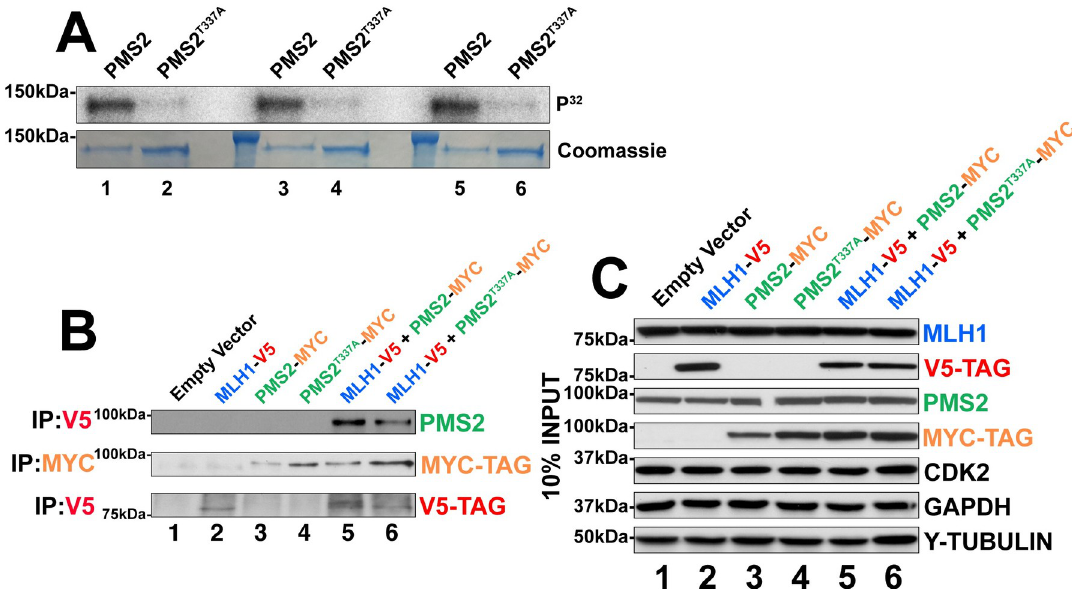
Fig 2. CDK2 phosphorylation of full-length PMS2 and its effect on the complex with MLH1. (A) CDK2/cyclin A2 kinase assay directed against GST-tagged fusion PMS2 (lanes 1,3,5) or PMS2 T337A (lanes 2,4,6) full length proteins. Upper panel shows the phospho- image of each protein and represents the amount of radiolabelling occurring following phosphorylation by CDK2/cyclin A2. The lower panel shows the Coomassie staining of radiolabelled proteins to indicate equal loading in each lane. (B) IP-western blot analysis of transfected MLH1-V5 or PMS2-MYC proteins from HEK293T cells. Antibodies used for immunoprecipitation are shown at the left hand side whilst antibodies used for detection are shown on the right hand side of the blot. Correct expression of tagged proteins is detected by the V5 or Myc tag following their respective immunoprecipitation (2 nd and 3 th panels from top, respectively). Co- immunoprecipitation of MLH1-V5 with PMS2-myc or PMS2 T337A -myc is shown in lanes 5 and 6. (C) Input western blot of lysates used for panel A. Here 10% of the total protein used for immunoprecipitation in panel A was probed for proteins relevant for the assay. CDK2, GAPDH and gamma-TUBULIN are shown as loading controls. Molecular weight markers in kDa are indicated on the left.